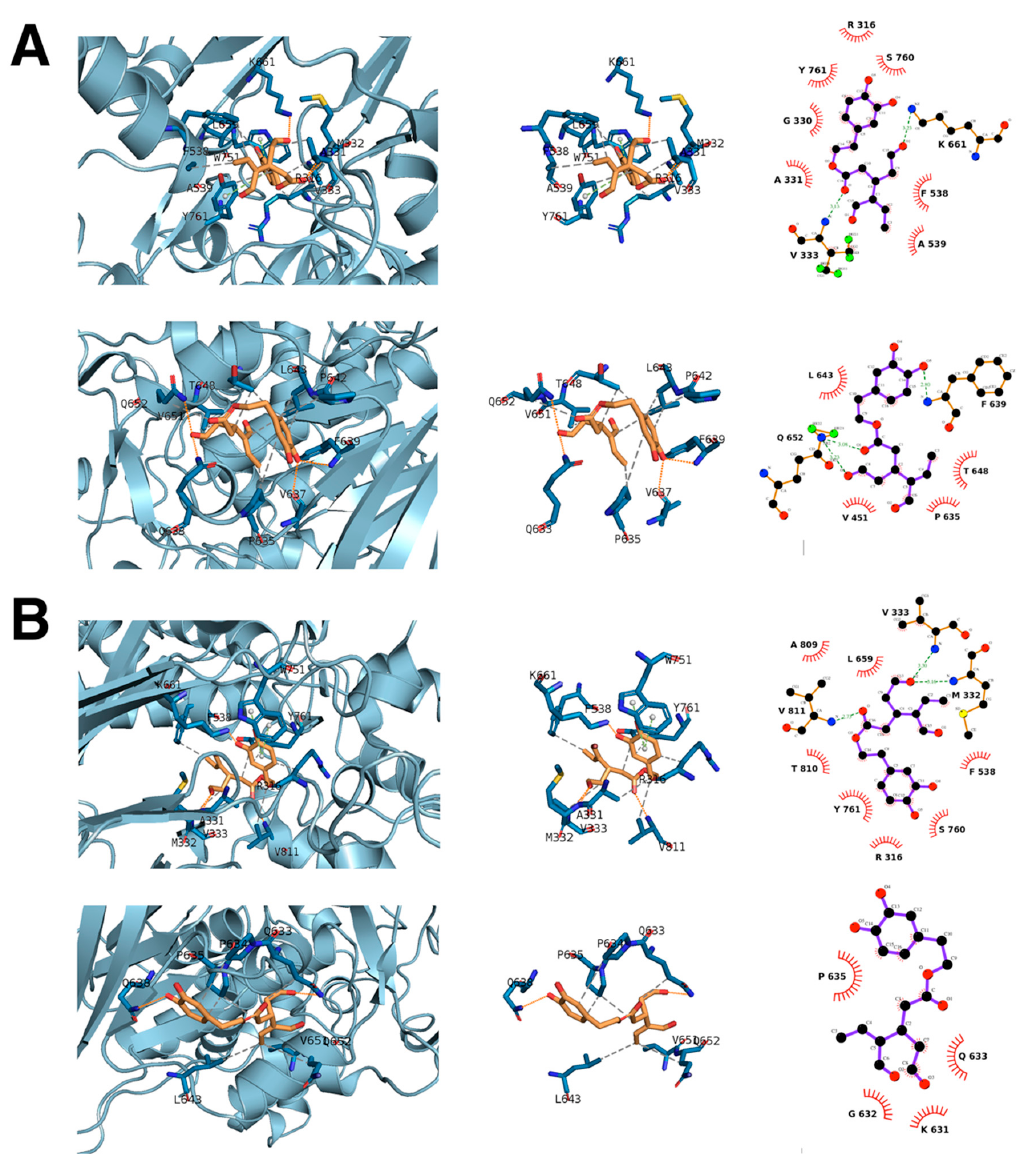
Figure 1. Structural analysis of oleacein binding to LSD1. Left panels show in sticks the interaction residues between oleacein and LSD1 (PDB: 2IW5) represented in the cartoon using PLIP. Middle panels show all the residues involved in oleacein binding using PLIP. Hydrogen bond interactions are represented by orange dashed lines; salt bridges are represented by yellow dashed lines and charge centers by yellow spheres; cation- π interactions are represented by blue dashed lines and white